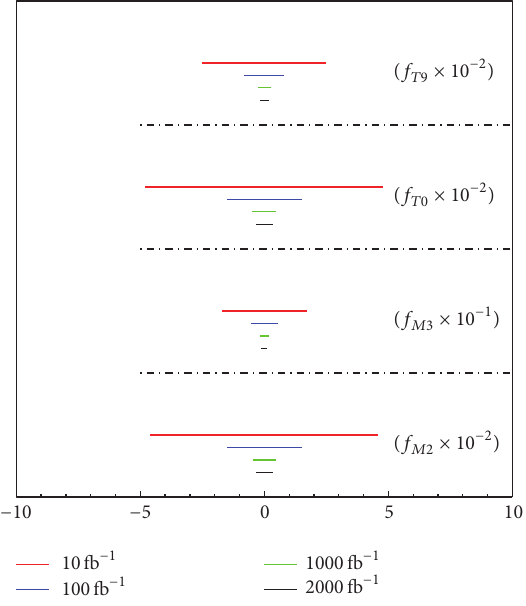
Figure 5: 95% CL sensitivity bounds of 𝑓 𝑀2 /Λ 4 , 𝑓 𝑀3 /Λ 4 , 𝑓 𝑇0 /Λ 4 , and 𝑓 𝑇9 /Λ 4 couplings for various values of integrated luminosities and √𝑠 = 3 TeV through the process 𝛾𝛾 → 𝑍𝑍 .